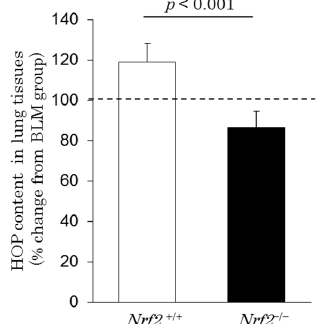
Figure 7. Hydroxyproline (HOP) content in the lung tissues on day 28 after BLM injection and after exposure to DE for a maximum of 56 days. The vertical axis shows percentage changes in the HOP content of the DE plus BLM group relative to the BLM group. Data are shown as mean ± SD values in the Nrf2 +/+ group ( n = 5) and Nrf2 − / − group ( n = 6).